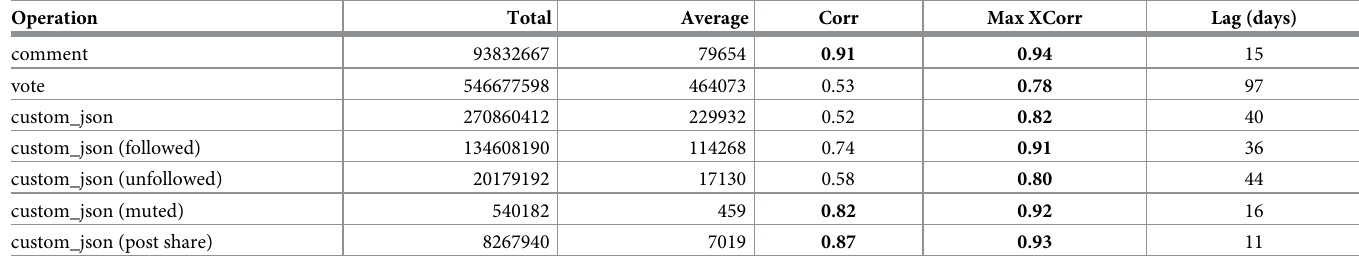
Table 2. Social actions and cross-correlations with STEEM price. The column “Total” reports the overall volume of operations during the observation period. The sec- ond column reports the average daily volume. In the last three columns we report the cross-correlation, the maximum cross-correlation and the lag with the highest cross- correlation,